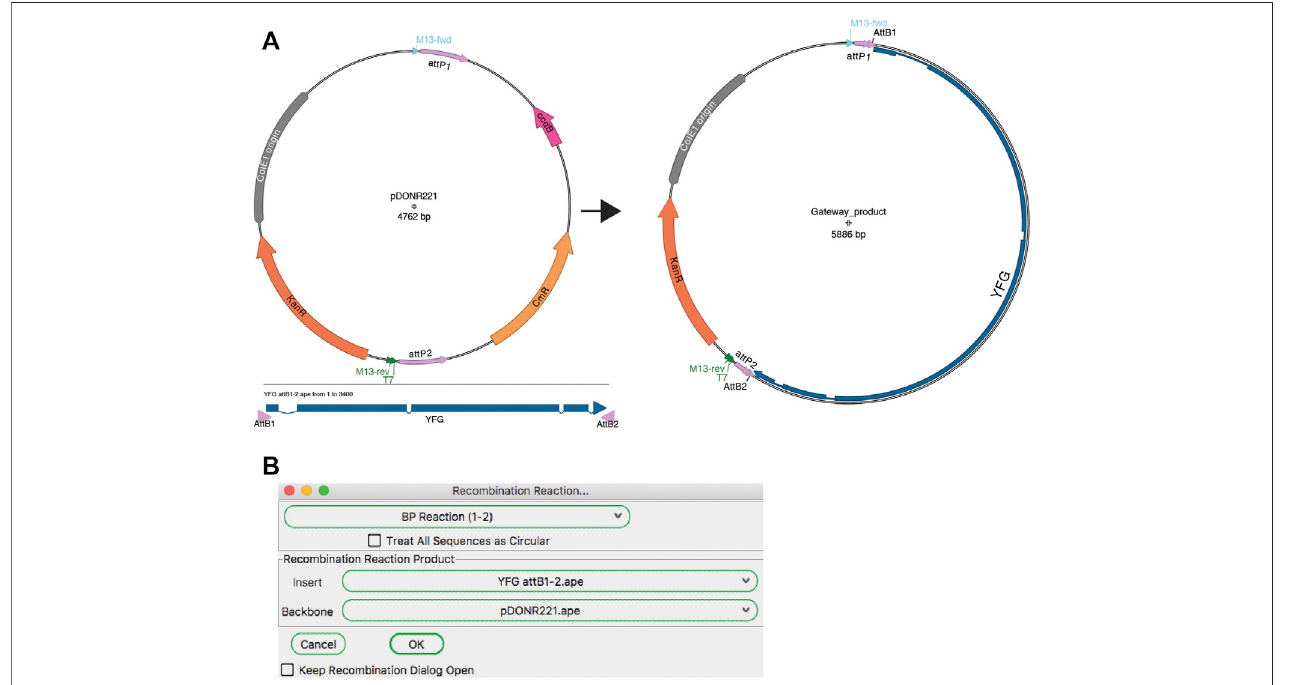
FIGURE 8 | Gateway reaction. (A) Graphic map of the input sequences for a Gateway BP reaction (left) and the product of the recombination (right). (B) The RecombinationAssemblertoolisusedtoselectthetwoinputsequences(InsertandBackbone).Thetoolthengeneratestheproductsequence,representedbythemap in (A)